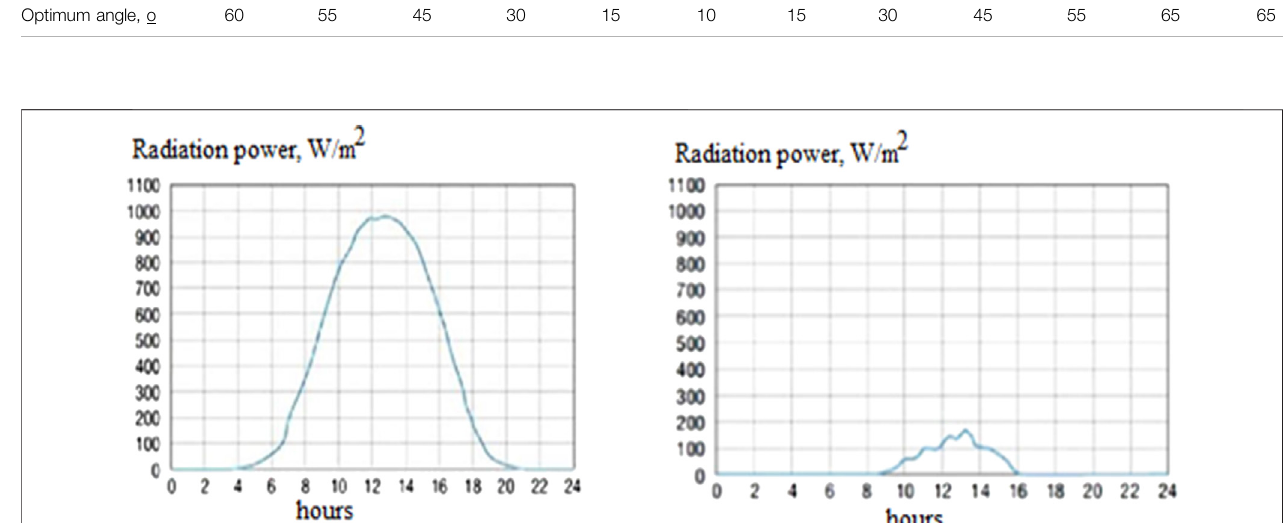
FIGURE 3 | Daily radiation power in Poland: (A) on a cloudless day in June, (B) on a cloudy day in December (weather data and software for solar power investments,